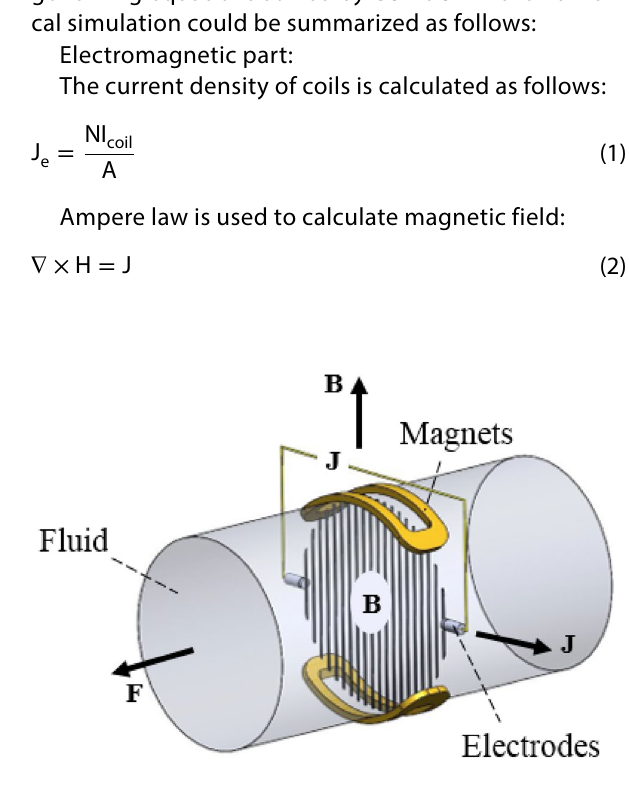
Fig. 1 The structure of the electromagnetic